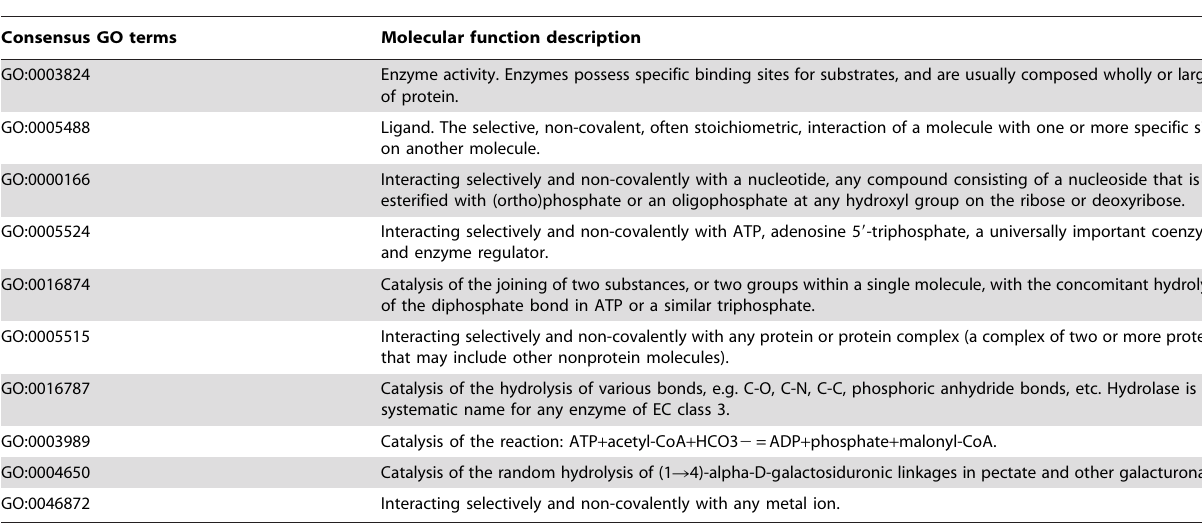
Table 4. Molecular function of predicted consensus GO terms for the PPR